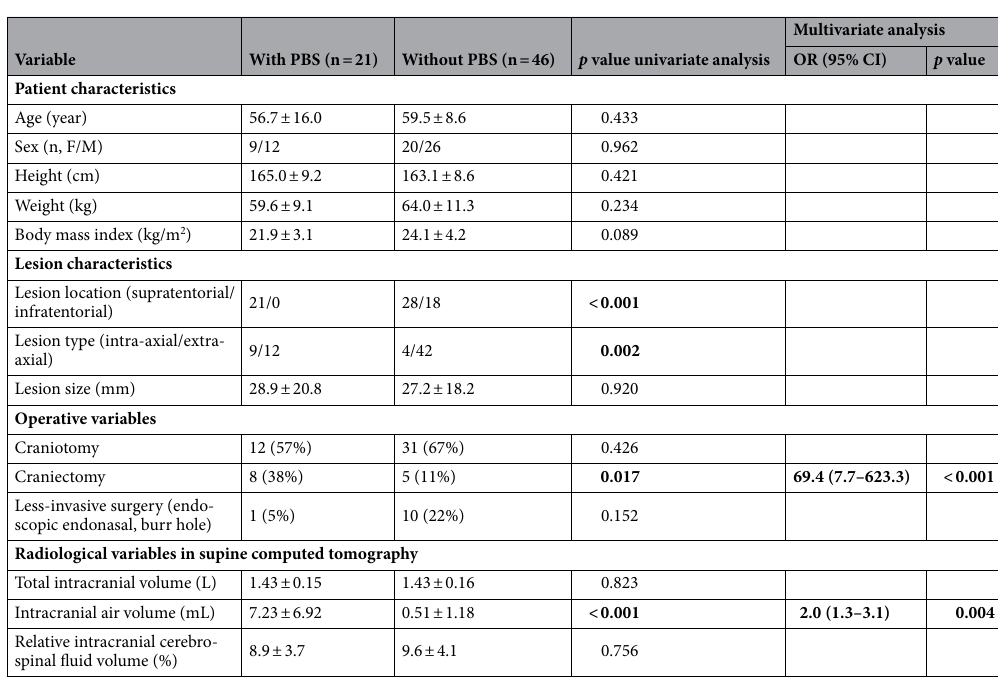
Table 2. Comparison between patients with and without positional brain shift (≥ 5 mm). Significant values are in [bold]. CI confidence interval, OR odds ratio, PBS positional brain shift.